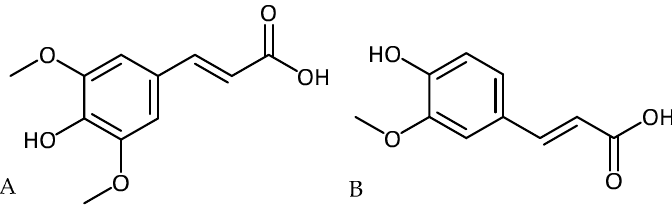
Figure 14. Structure of ( A ) sinapic acid and ( B ) ferulic acid.